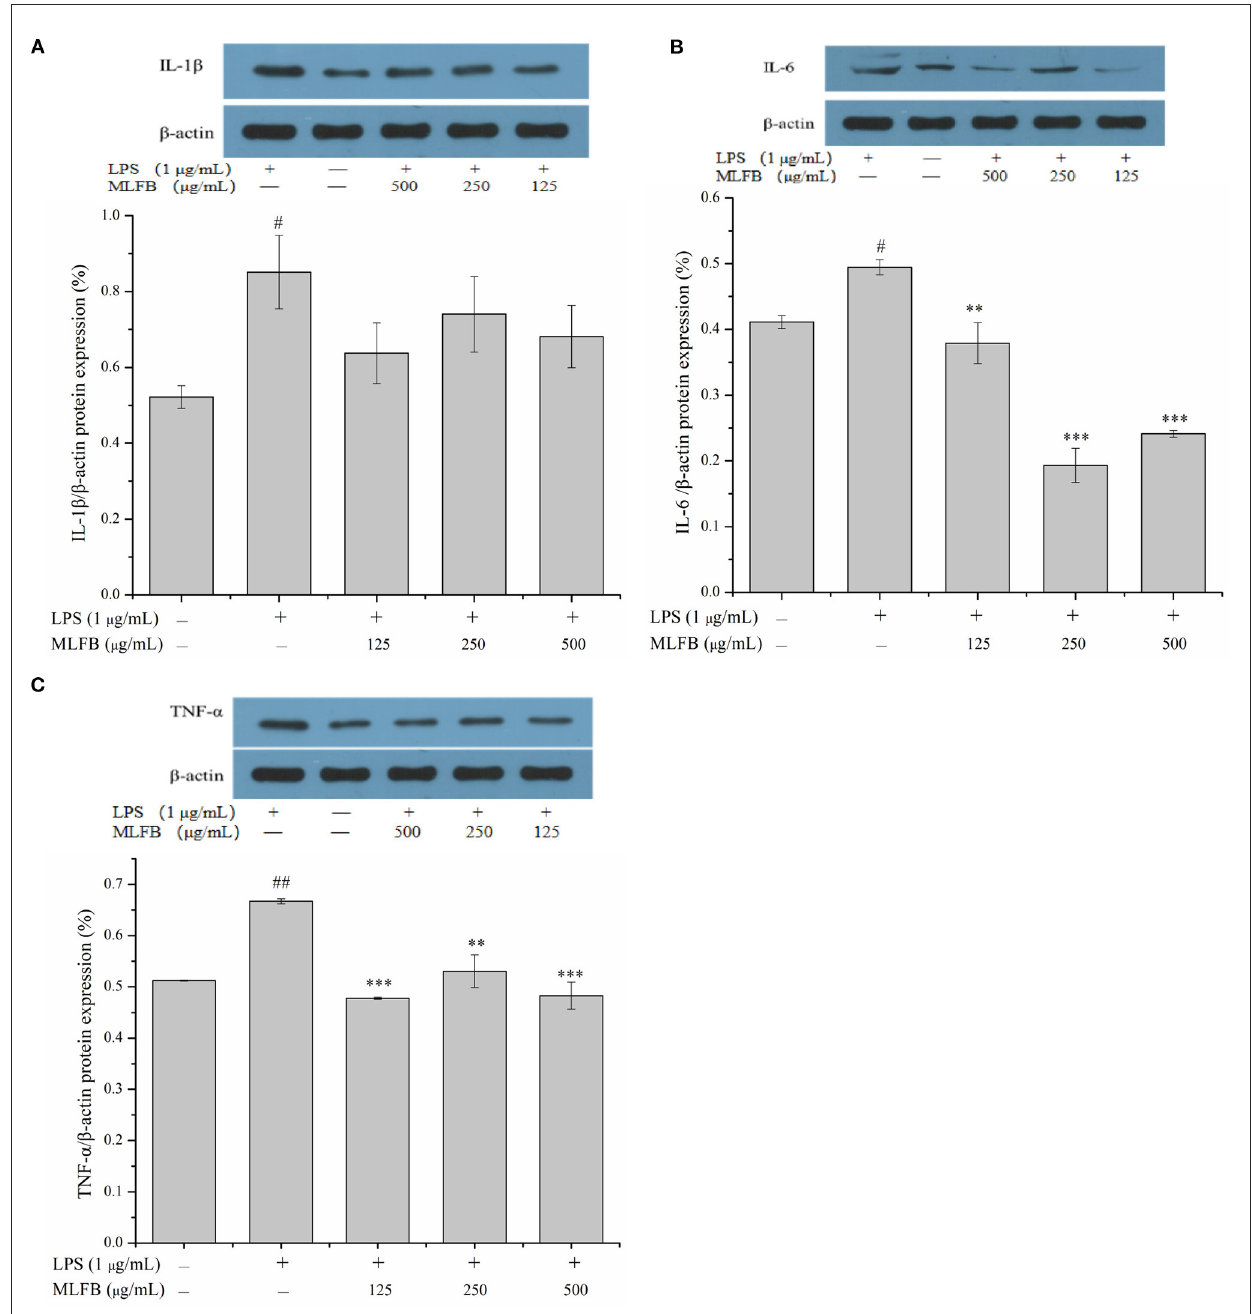
FIGURE4 Effects of MLFB on the protein expressions of IL-1 β (A) , IL-6 (B) , TNF- α (C) in LPS-induced RAW 264.7 cells. # Means statistical difference compared with blank control group ( # P < 0.05, ## P < 0.01). *Means statistical difference compared with LPS-induced inflammatory model group (** P < 0.01, *** P <